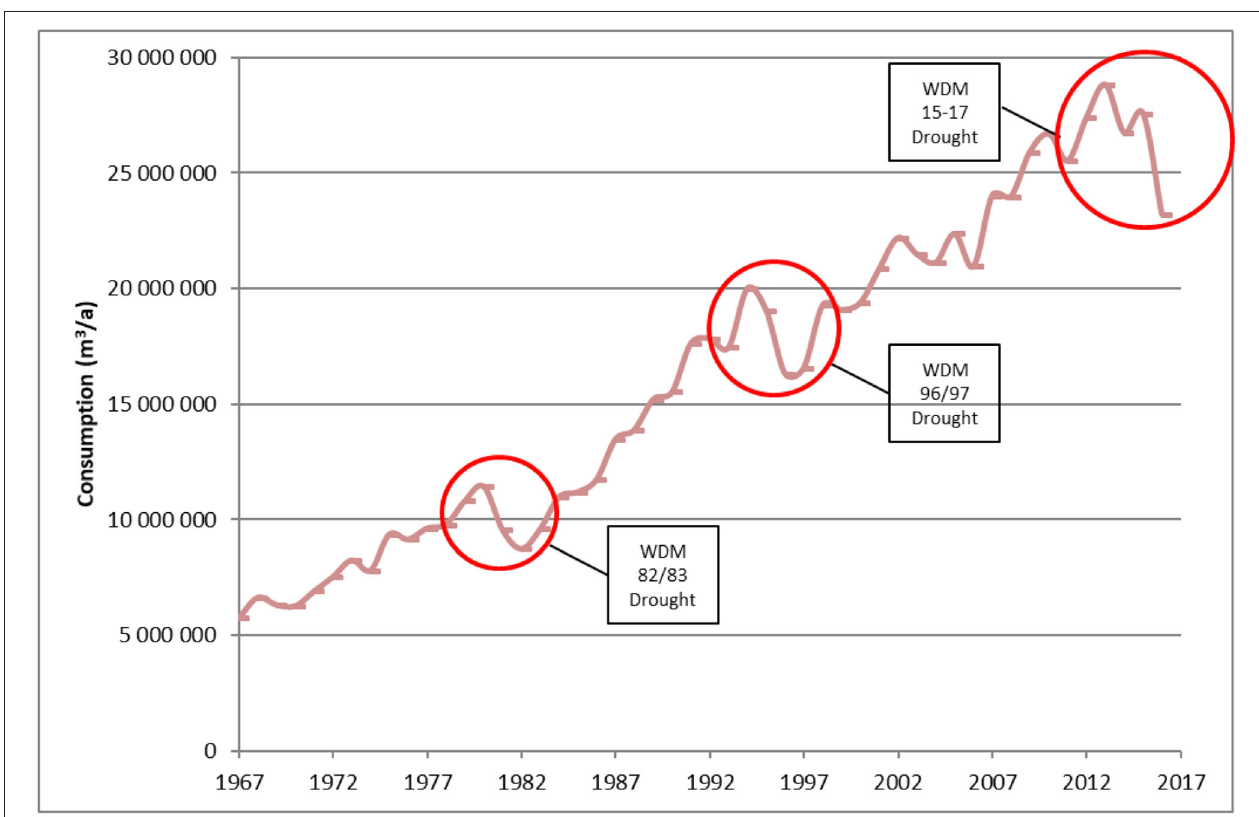
FIGURE 4 | Periodic water demand management successes in Windhoek (CoW Operational